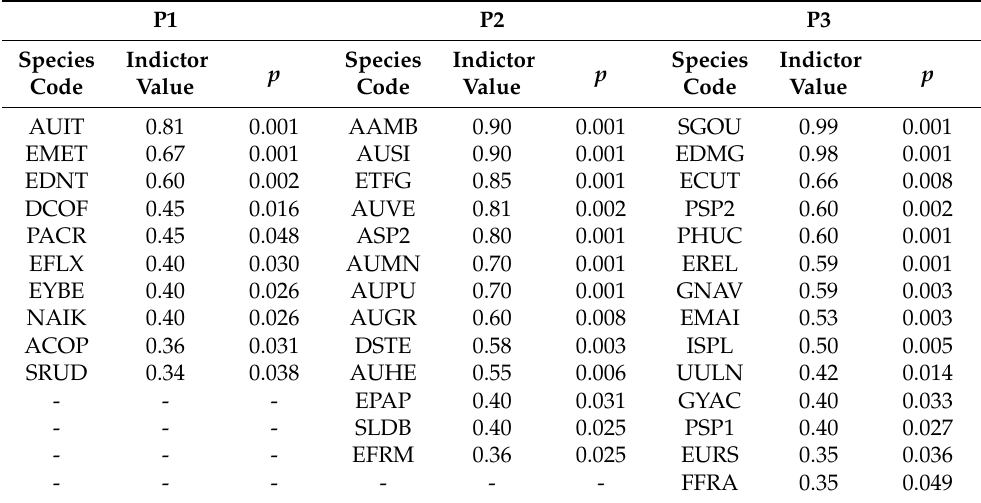
Table 4. Species with significant indicator value for all Ponds. The codes of the diatom species were assigned according to the OMNIDIA